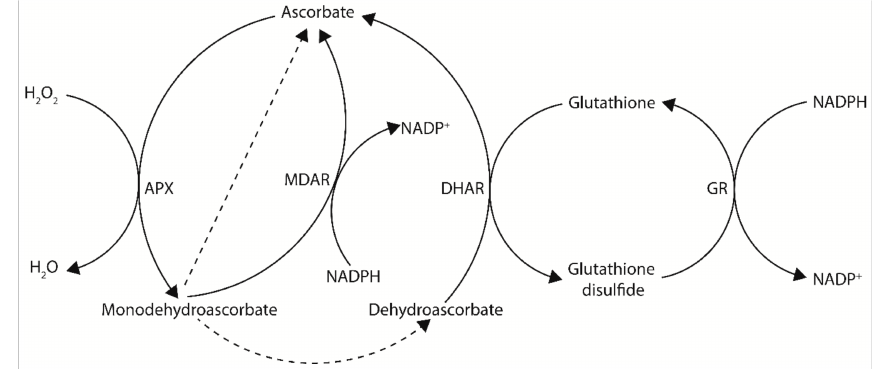
Figure 1. The ascorbate–glutathione cycle—a major antioxidant system of plants cells. In this cycle, electrons flow from NADPH to H 2 O 2 . Dashed arrows indicate non-enzymatic disproportionation. APX, ascorbate peroxidase; MDAR, monodehydroascorbate reductase; DHAR, dehydroascorbate reductase; GR, glutathione